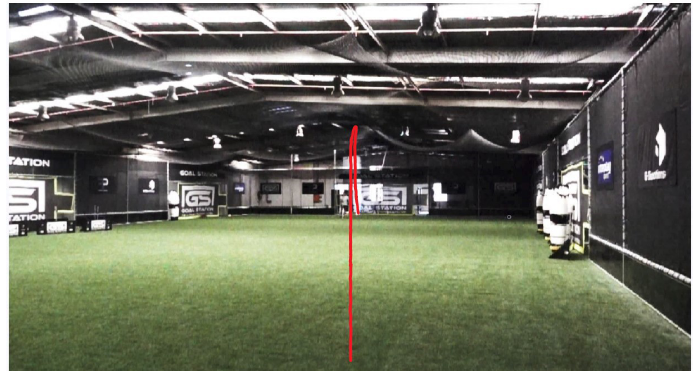
Figure 13. Example of knuckle ball trajectory of soccer